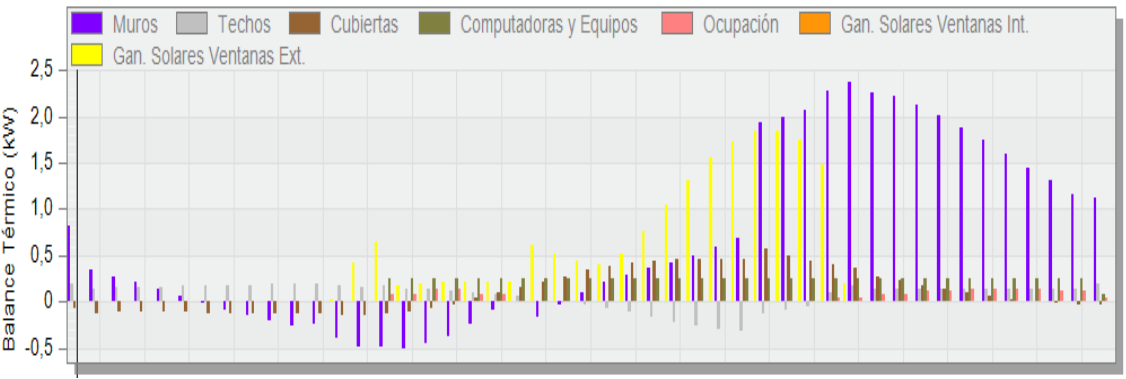
Figure 7 . Internal gains plus solar gains in studio architecture